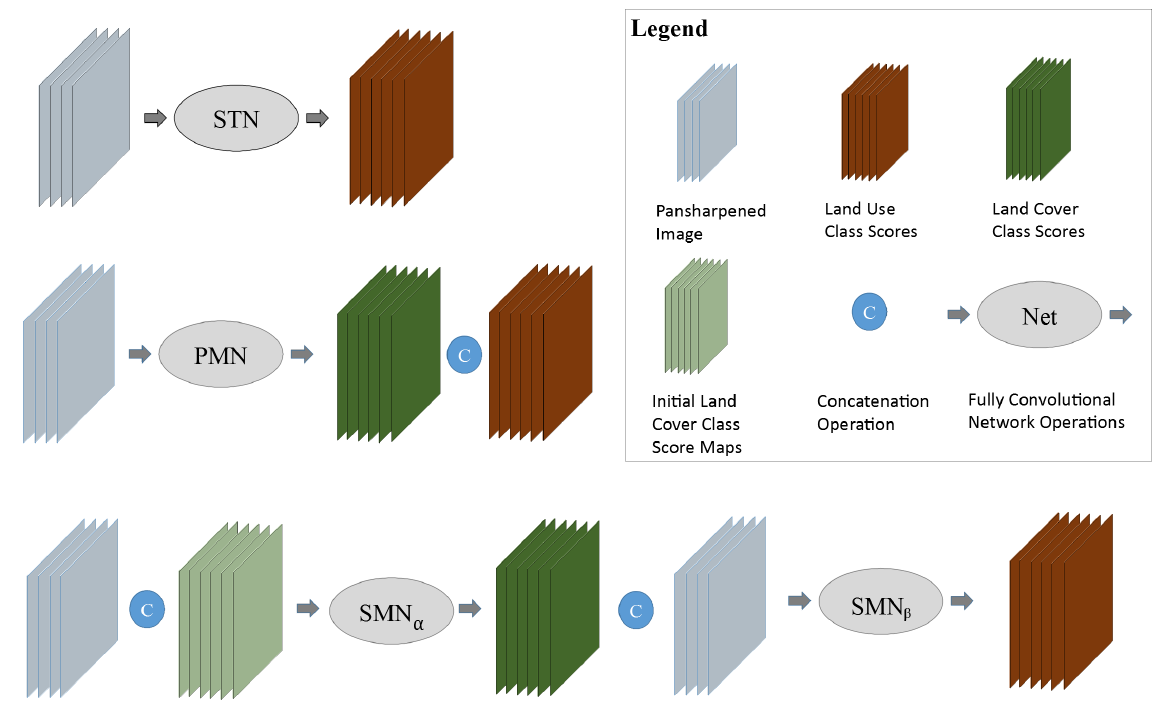
Figure 2. Illustration of the three different fully convolutional networks. STN (single task network) is a standard network only predicting the land use class of each pixel in the image. PMN (parallel multitask network) is a multitask network that concatenates the land use and land cover class labels in the same output layer of the network while SMN (sequential multitask network) accept as an input the land cover predictions, predicted by a subpart of the network, concatenated to the original input image